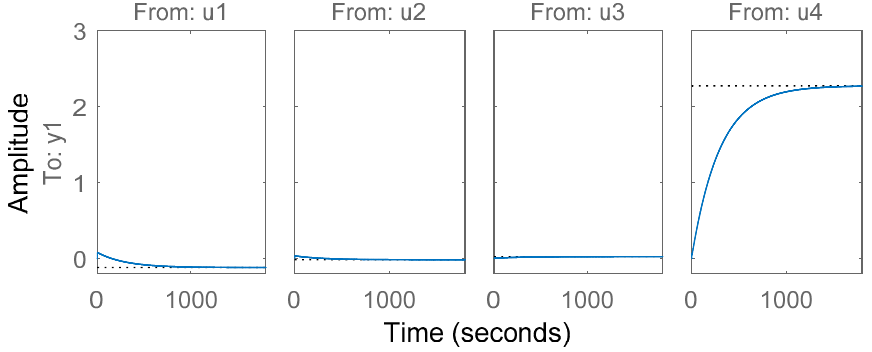
Figure 11. Step responses of the ARX model for evaporation rate prediction. u1: primary air; u2: secondary air; u3: stoker speed; and u4: fuel moisture content.